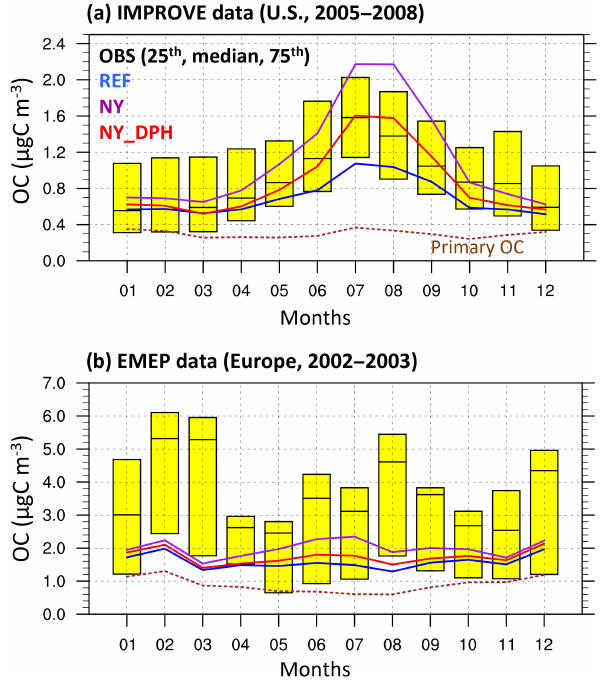
Figure 5. Monthly average OC concentrations as predicted by the GEOS-Chem 2005–2008 simulations and as measured by (a) the IMPROVE network (2005–2008) and (b) the EMEP net- work (2002–2003). The yellow boxes show the observed medians, 25th and 75th quintiles reflecting the spatial (among stations) and temporal (among years) variability. The predicted OC medians are shown for the REF (blue), NY (purple) and NY_DPH (red) simula- tions. The predicted primary OC is also shown (brown dashed line) and is similar for all